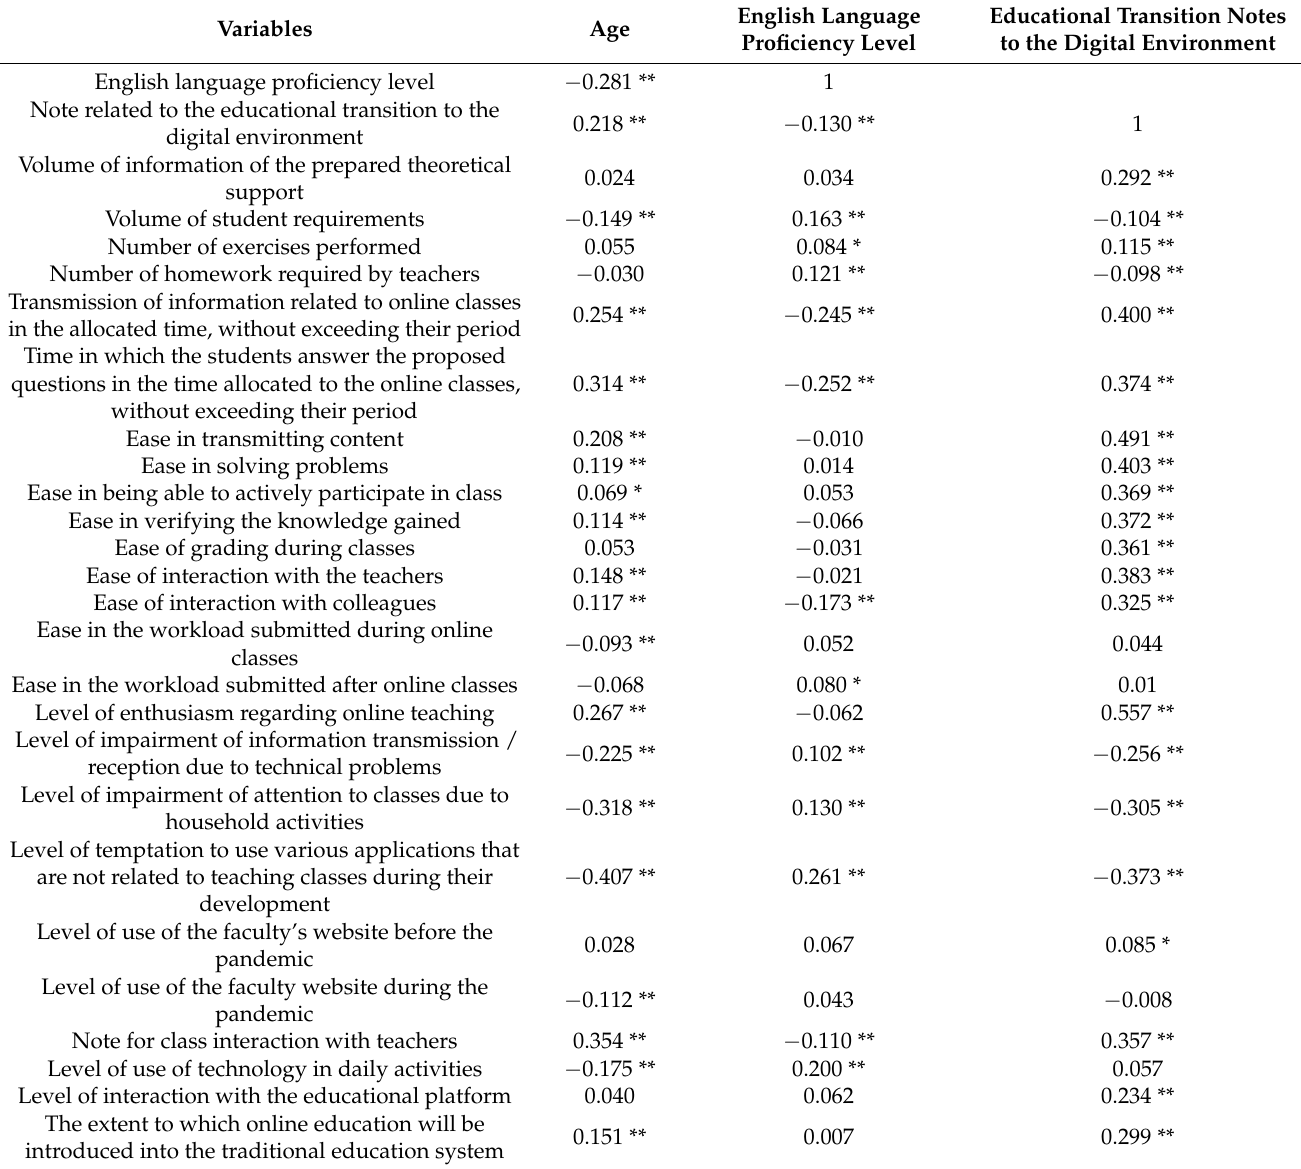
Table 16. Correlations between students’ age, English language proficiency level, educational transi- tion note to the digital environment, and other